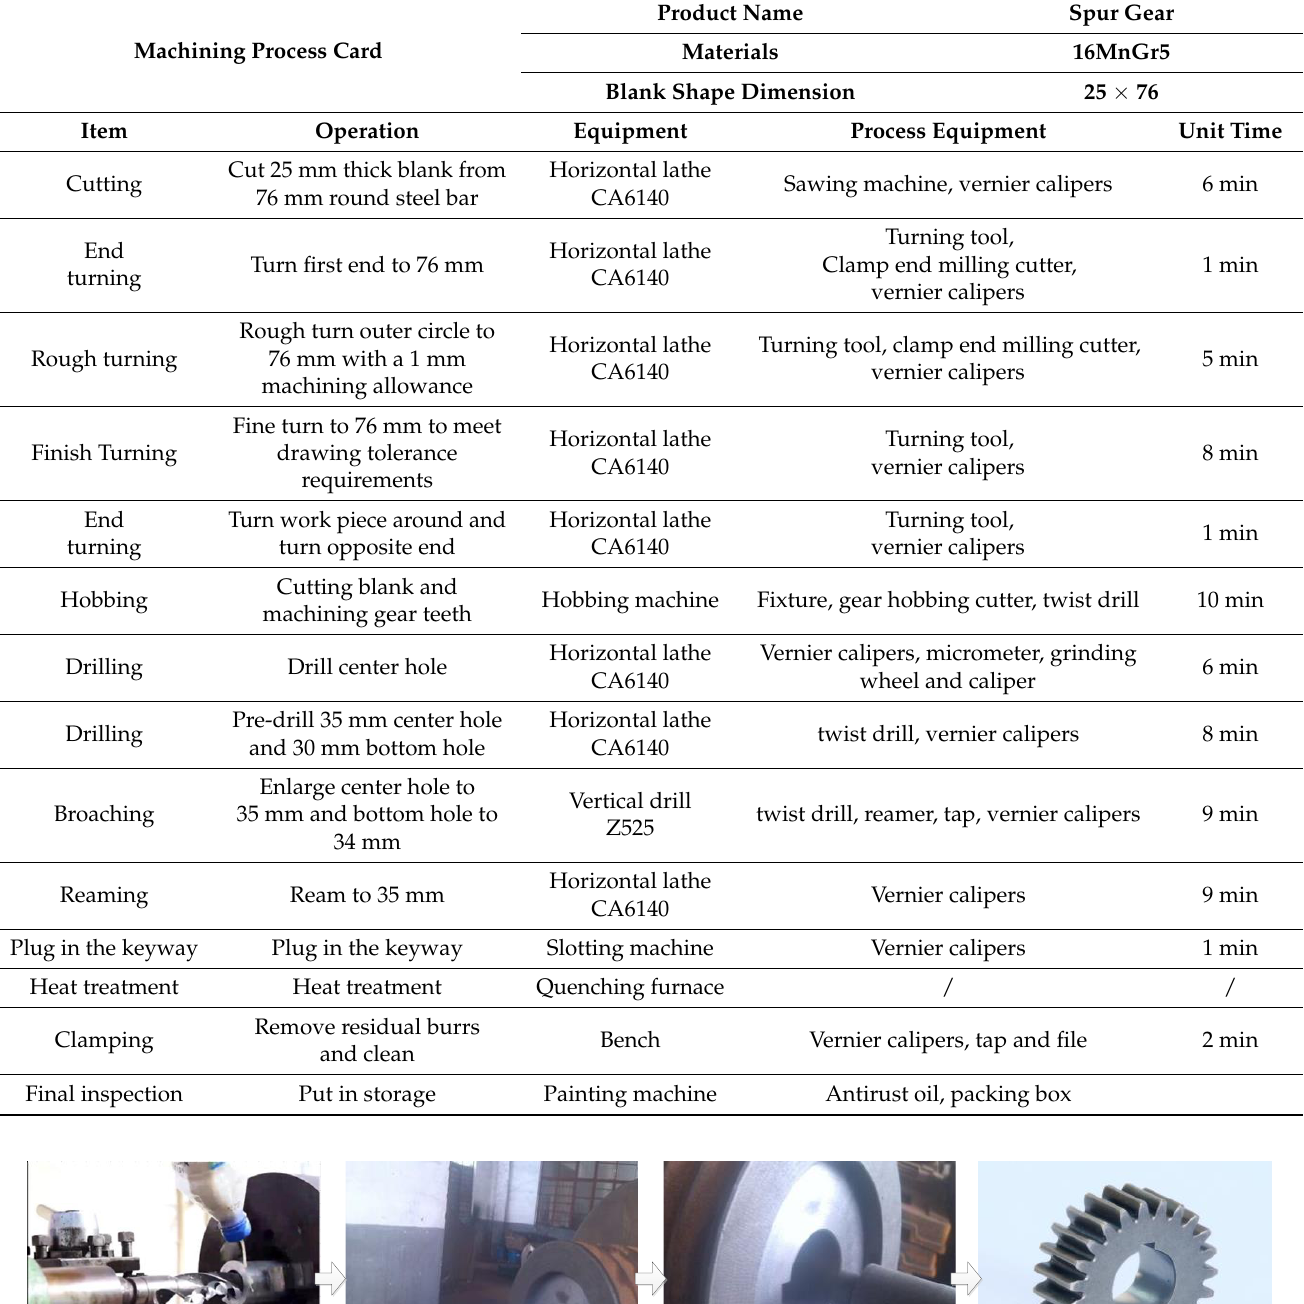
Table 1. Process card of spur gear machining.